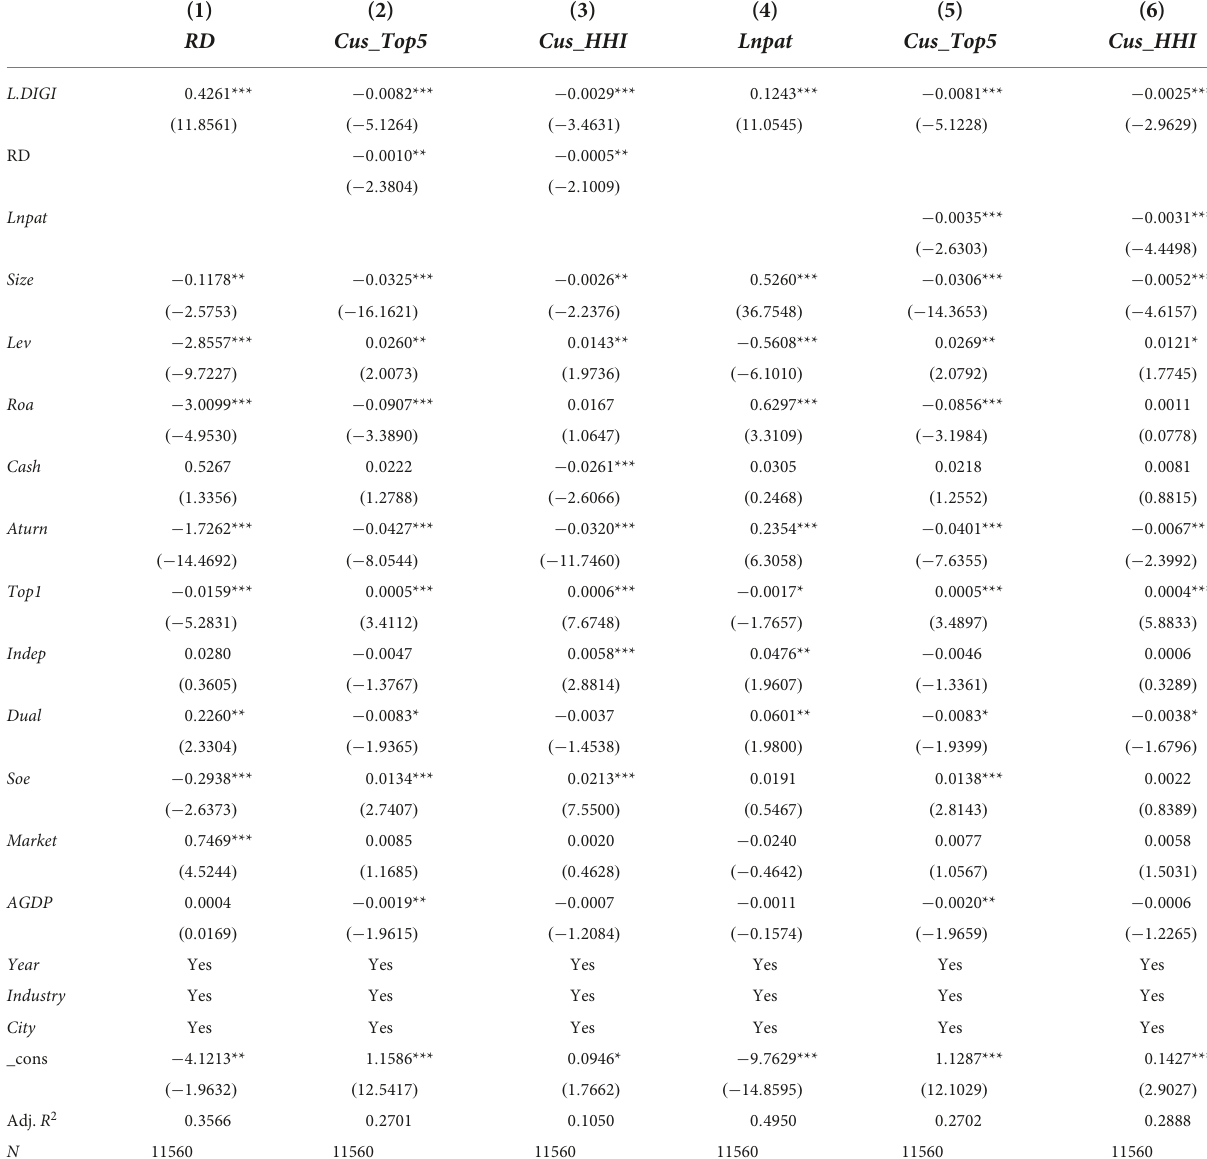
TABLE 7 Test results of mediating effects of firms’ innovation